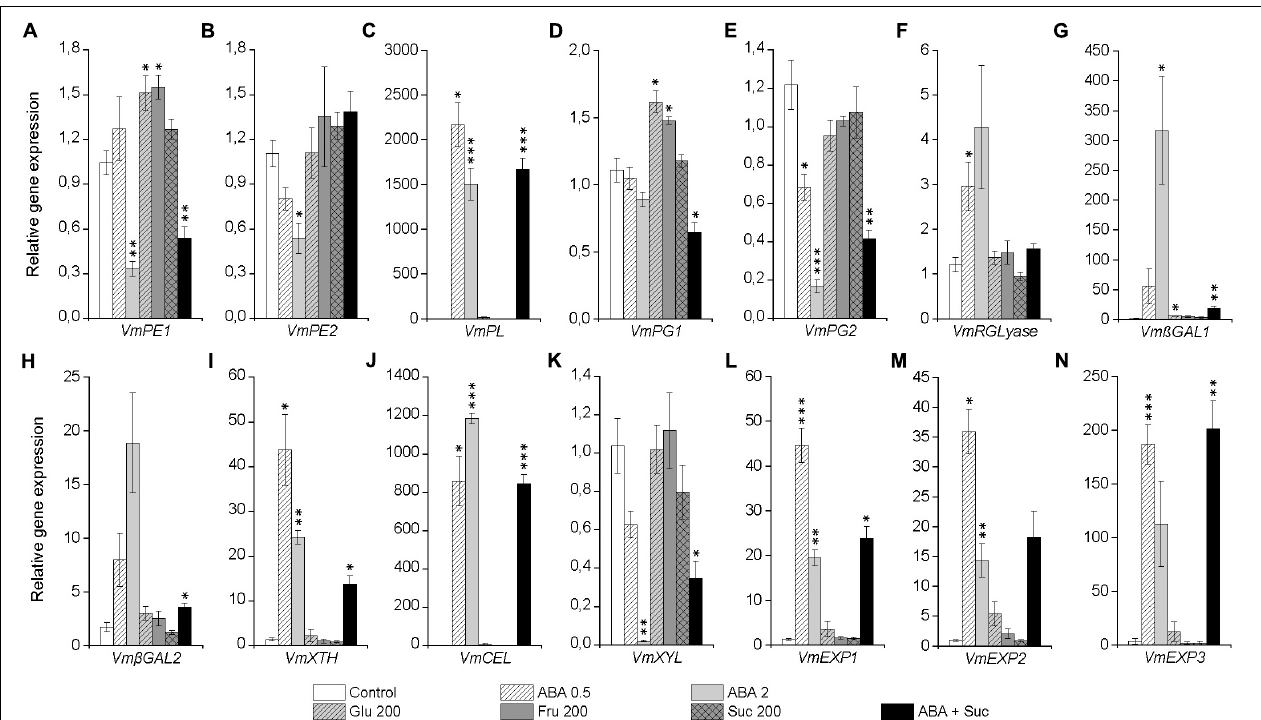
FIGURE 7 | Effect of post-harvest ABA and sugar treatments on the expression cell wall modifying genes VmPE1 (A) , VmPE2 (B) , VmPL (C) , VmPG1 (D) , VmPG2 (E) , VmRGLyase (F) , Vm β GAL1 (G) , Vm β GAL2 (H) , VmXTH (I) , VmCEL (J) , VmXYL (K) , VmEXP1 (L) , VmEXP2 (M) , and VmEXP3 (N) in bilberry fruit. The treatments were: ABA (0.5 and 2 mM), glucose (200), fructose (200 mM), sucrose (200 mM), 0.5 mM ABA + 200 mM sucrose, or water (control). Relative expression of the genes was quantified by qRT-PCR after 4 days of the beginning of the experiment and normalized to VmGAPDH . Values represent means ± SEs of three replicates. PE , pectin esterase; PL , pectate lyase; PG , polygalacturonase; RGLyase , rhamnogalacturonate lyase; β GAL , β -galactosidase; XTH , xyloglucan endotransglycosylase/hydrolase; CEL , endo- β - 1,4 glucanase: XYL , β -xylosidase; EXP , expansin. Asterisks indicate significant differences from control in Student’s t -Test ( ∗ P ≤ 0.05, ∗∗ P ≤ 0.01, ∗∗∗ P ≤